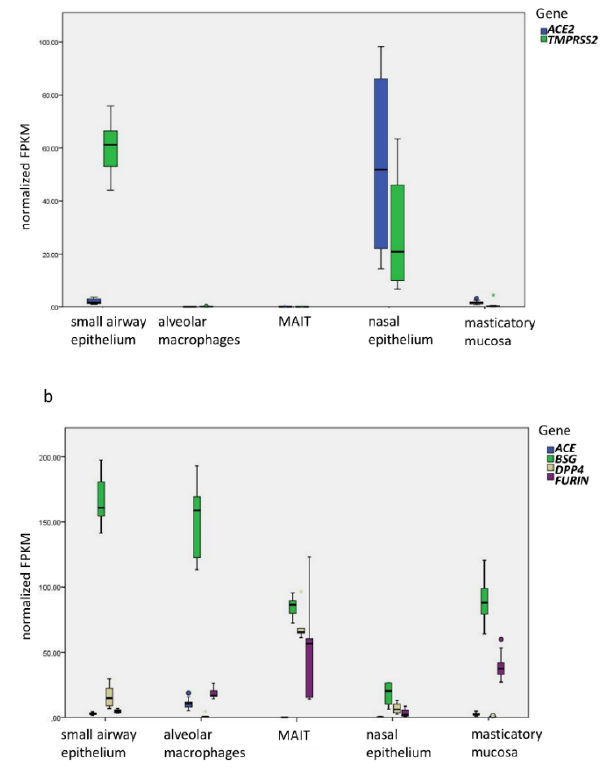
Figure 1. The expression of SARS-CoV-2 entry genes. ( a ) Established SARS-CoV-2 entry genes, ACE2 Figure1. TheexpressionofSARS-CoV-2entrygenes. ( a )EstablishedSARS-CoV-2entrygenes, ACE2 and and TMPRSS2 , in five different types of samples. The difference between ACE2 and TMPRSS2 in the TMPRSS2 , in five di ff erent types of samples. The di ff erence between ACE2 and TMPRSS2 in the small airway epithelium is highly significant ( p = 1.00 × 10 -12 ). In the nasal epithelium, the expression of ACE2 is significantly higher than that in small airway epithelium ( p = 6.92 × 10 − 4 ), alveolar macrophages ( p = 5.02 × 10 − 4 ), MAIT ( p = 0.016), and masticatory mucosa ( p = 5.48 × 10 − 7 ); the expression of TMPRSS2 is lower than that in small airway epithelium ( p = 5.20 × 10 − 3 ), but higher than in alveolar macrophages ( p = 2.98 × 10 − 3 ), MAIT ( p = 0.040), and masticatory mucosa ( p = 1.40 × 10 − 5 ). ( b ) The expression of ACE and possible SARS-CoV-2 alternative entry genes, BSG , DPP4 , and FURIN . Y-axis represents normalized FPKM values by the average of relative levels of 6 HKGs. The boxplot produced by the IBM SPSS Statistics Version 23 shows the mean, the first quartile and the third quartile, and the 95% confidence interval (CI). FPKM: fragments per kilobase of transcript per million mapped